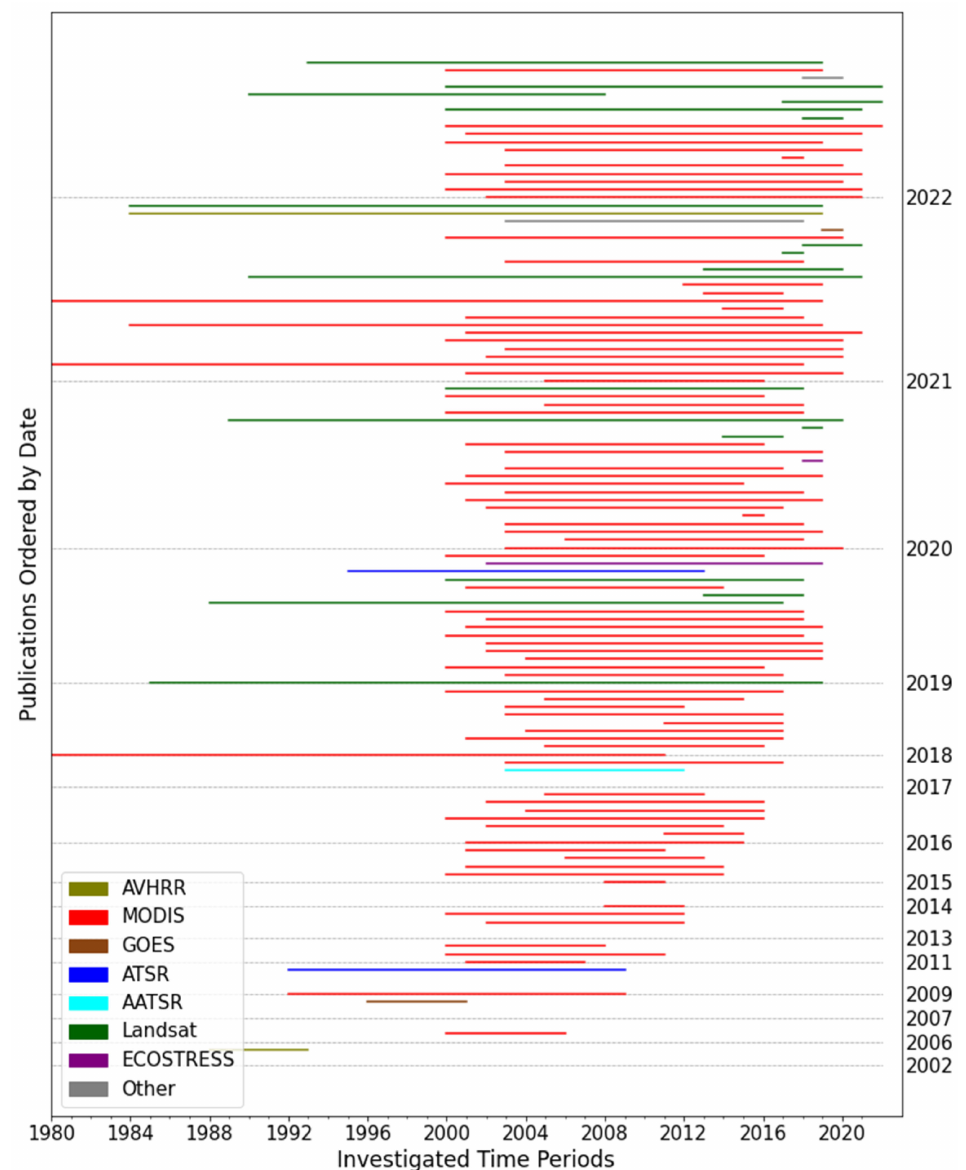
Figure 10. Investigated study periods ( x -axis) for every reviewed study employing a time series. The y -axis visualizes the year of publication. The colors represent the employed sensors. Studies employing multiple sensors are displayed several